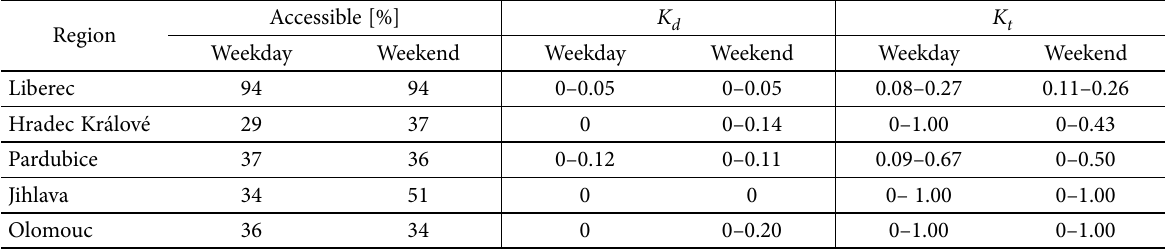
Table 3. Accessibility of trains in the Czech